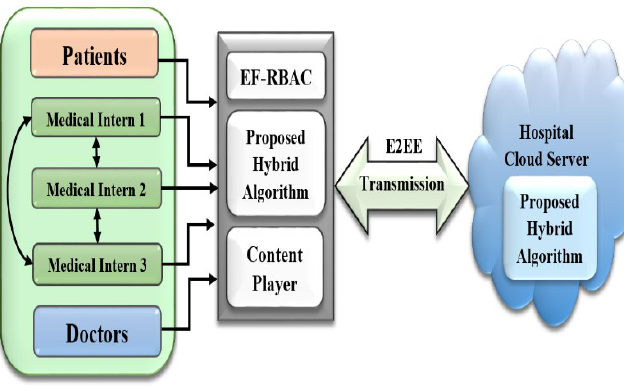
Figure 5. Hospital e-Record Cloud Management System